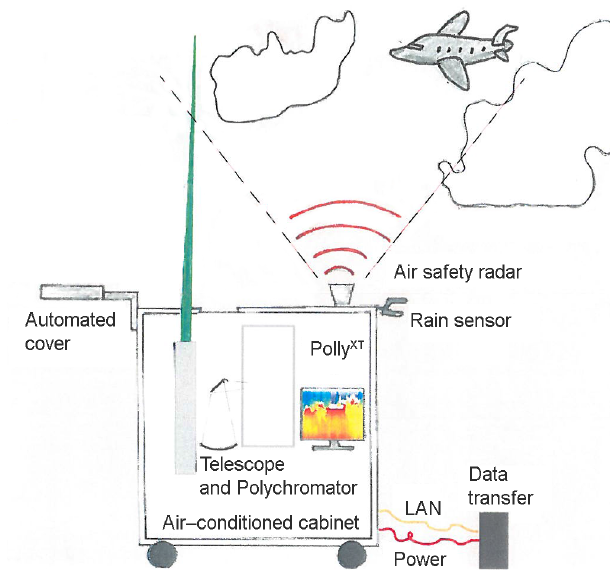
Figure 2. The general concept of Polly. These unattended aerosol Raman lidars have already been deployed worldwide for campaigns with periods on the order of 1year. They are completely controlled via remote access, automatically shut down in events of rain, can be connected to an air-safety radar, and transfer the data to a central- ized data server where the data are archived and automatically eval- uated. Issues with data quality can thus be quickly identified and the users are informed. The system’s mass is approximately 500kg, but they can be easily moved on the four wheels.